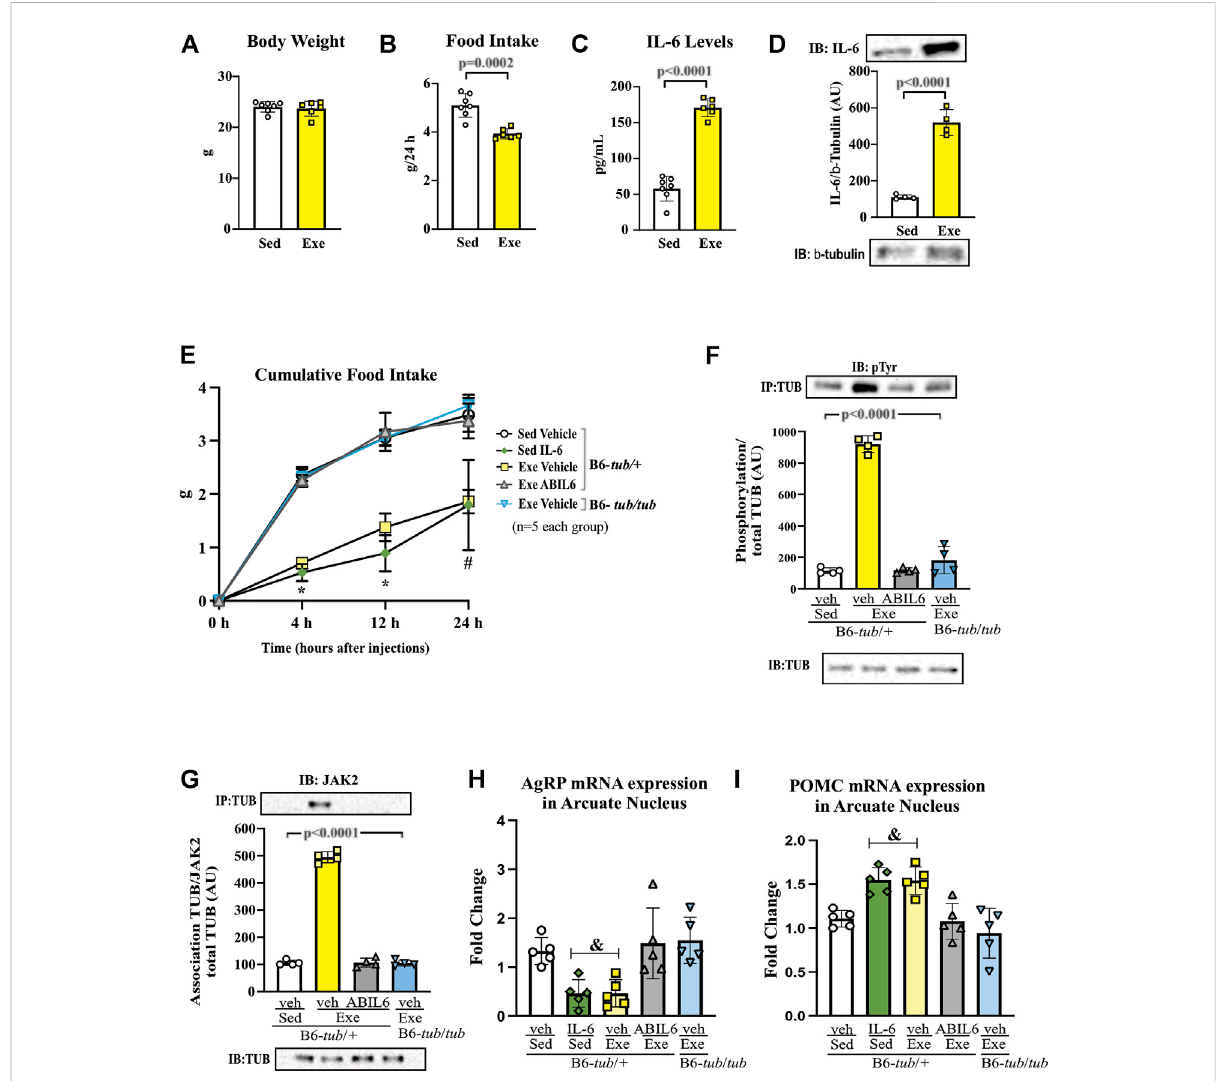
FIGURE 1 Effects ofacuteexercise onmetabolicparametersand TUBregulation. (A) Body weight (g); (B) 24 hoffoodintake(g); (C) serum IL-6 levels(pg/ ml); and (D) Western blot from hypothalamic lysates showing IL-6 expression in C57BL/6J mice (12 – 15 weeks of age) under resting conditions (Sed) orafterswimmingexercise(Exe).B6- tub/+ orB6- tub/tub mice(6 – 8 weeksofage)weredividedintothefollowinggroups:B6- tub/+ :sedentaryplus vehicle; sedentary plus IL-6 ICV; exercise plus vehicle; exercise plus ABIL6 (IL-6 antibody); B6- tub/tub : exercise plus vehicle. (E) Evaluation of the cumulative food intake (g) at 4 h, 12 h, and 24 h; (H) AgRP and (I) POMC mRNA expression in the arcuate nucleus of the hypothalamus. Western blot showing (F) TUB tyrosine phosphorylation and (G) TUB associated with JAK2 from hypothalamus lysates. The exercise was swimming. All mice were male. ICV: intracerebroventricular. All values are expressed as means ± standard deviation (SD). (A – C) : Sed ( n = 7) and Exe ( n = 6). (D,F,G) : ( n = 4eachgroup). (E,H,I) :( n =5eachgroup).Unpairedtwo-tailed t -testswereusedtoanalyze (A – D) ;two-wayANOVAwasusedtoanalyze (E) ;one-way ANOVAwithTukey ’ smultiplecomparisonstestswasusedto analyze (F – I) .* p < 0.0001vs.othergroups;& p < 0.05vs.othergroups; # [Sed